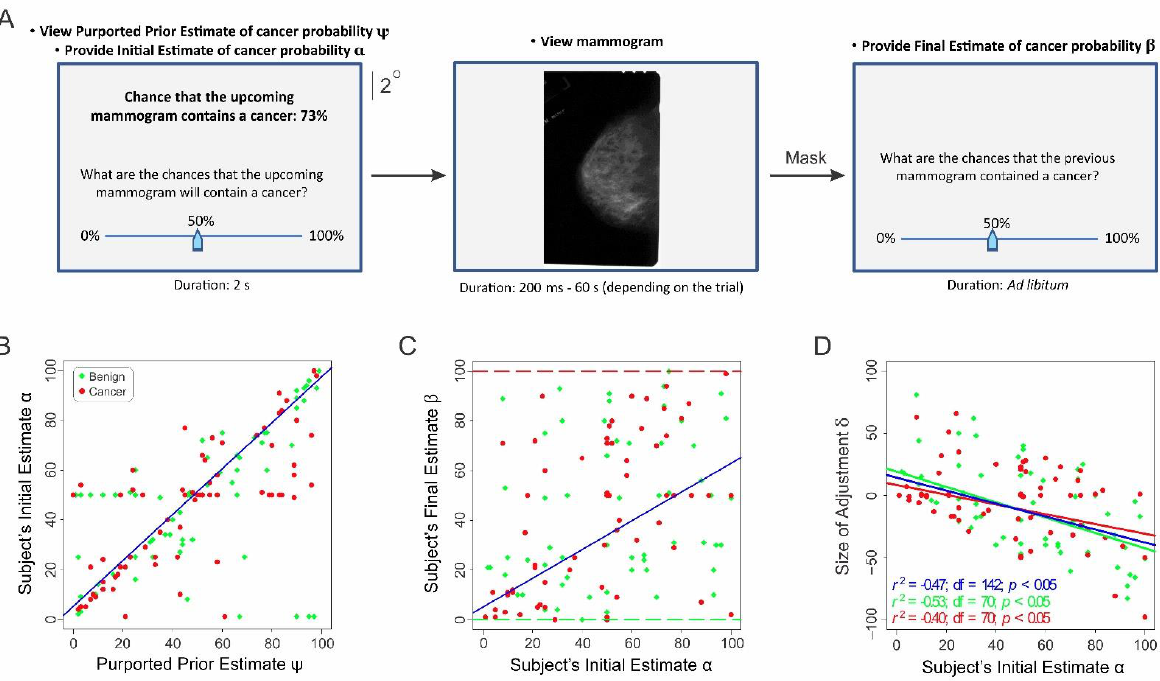
Figure 1. Task paradigm and results from Study 1. ( A ) Task paradigm. Each trial started with the onset of a central fixation spot, and each mammogram was followed by a 0.5 s random dot mask (not shown). Not drawn to exact scale. ( B – D ) Results. ( B ) Subjects’ initial estimate α as a function of the previous radiologist’s estimate ψ. ( C ) Subjects’ final estimate β as a function of their initial esti- mate α. The red and green dashed lines denote the expected responses for mammograms positive and negative for cancer, respectively. ( D ) The amount of the subjects’ adjustment δ as a function of their initial estimate α. The red, green, and blue dashed lines denote the best -fitting regression lines for all the mammograms, mammograms positive for cancer, and mammograms negative for cancer, respectively.